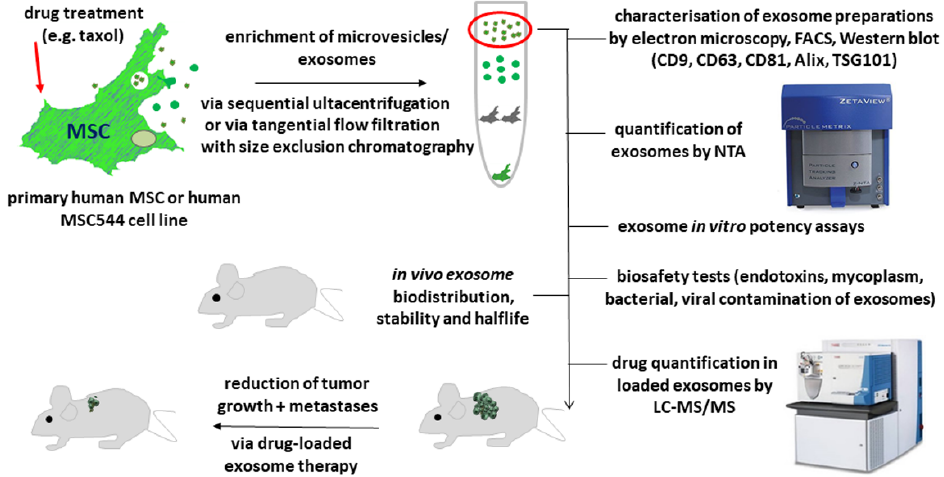
Figure 1. Drug-loading of human MSC-derived exosomes for in vivo antitumor application involves several steps of isolation and characterization. Primary human MSCs or the permanently growing human MSC544 cell line can be incubated with sub-lethal drug concentrations (e.g., 10 µ M taxol for up to 24 h) for incorporation of the drugs, packing into multivesicular bodies, and subsequently releasing drug-loaded exosomes into the conditioned medium. After removing the drugs by several washes and incubating the MSCs in drug-free and serum-free medium for a further 24 h, a microvesicular fraction including exosomes that are released into the conditioned medium can be enriched by different methods as suggested by protocols of Thery et al., together with the International Society of Extracellular Vesicles (ISEV) [29,30] and updated 2018 standards [31]. Enriched EVs/exosomes